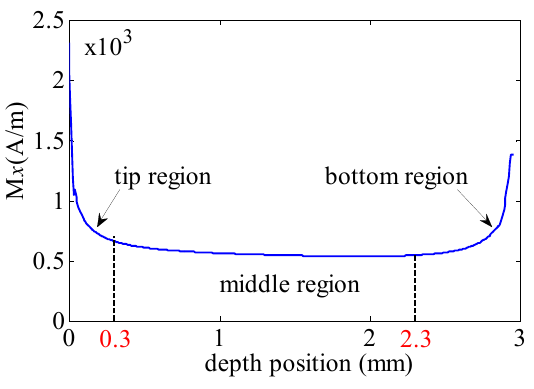
Figure 3. M x along the defect wall (l1).